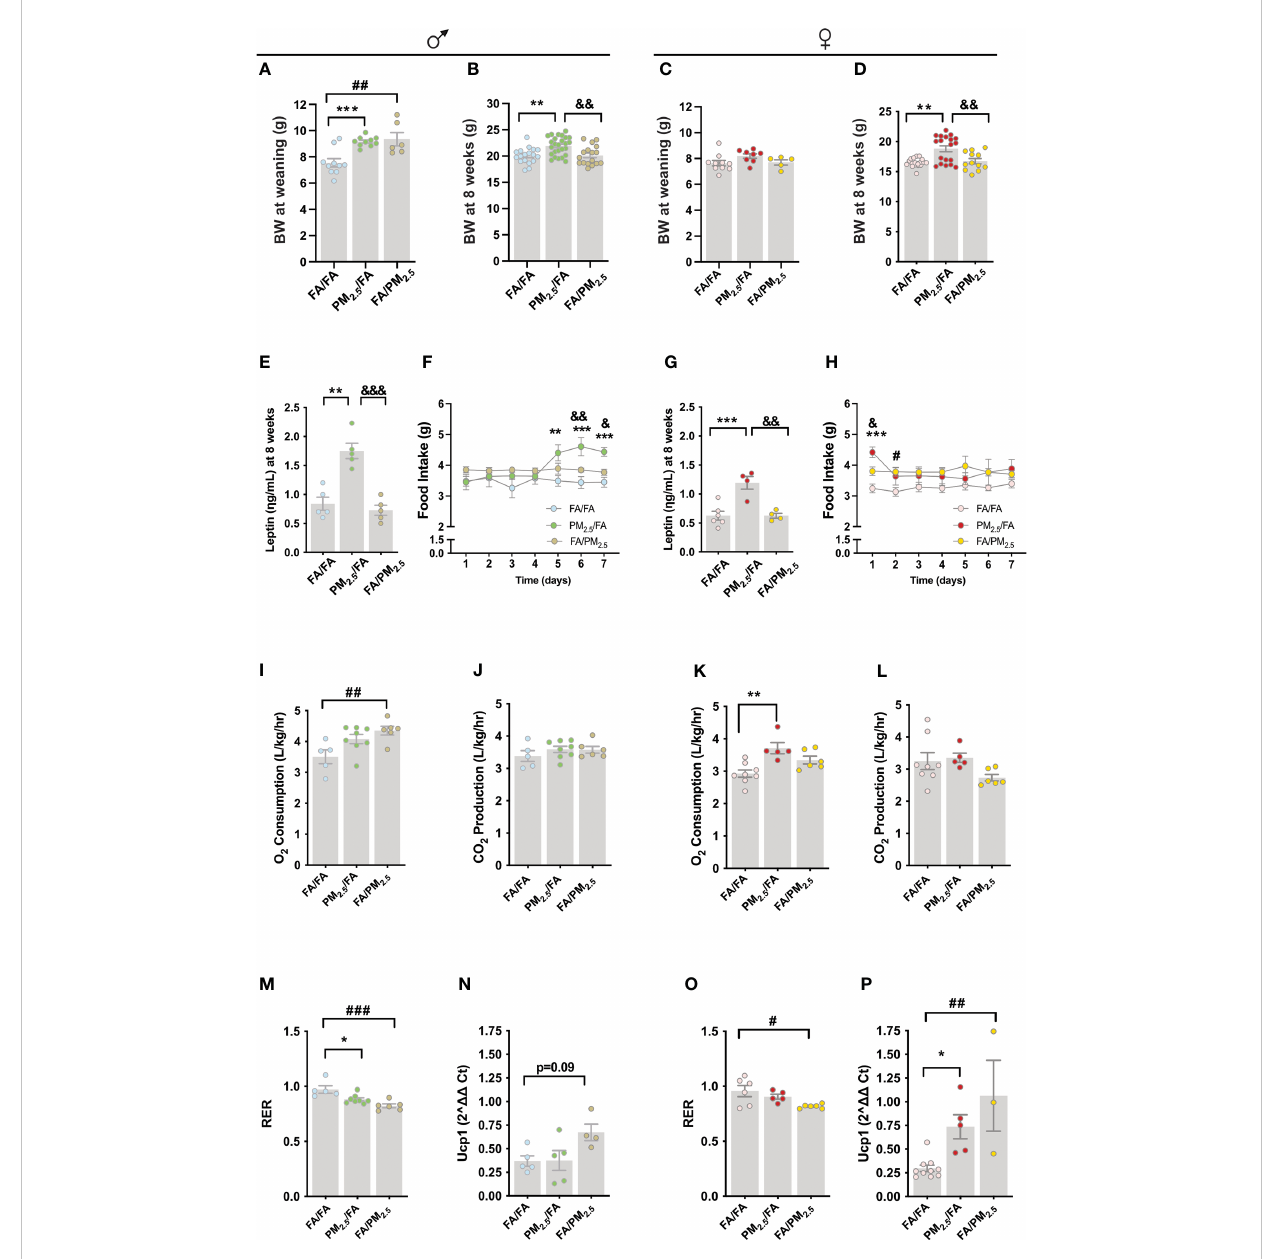
FIGURE 1 Maternal exposure to PM 2.5 alters the energy metabolism of the offspring. (A) Male offspring body weight (g) at weaning, n=6-10. (B) Male offspring body weight (g), n=17-26. (C) Female offspring body weight (g) at weaning, n=5-10. (D) Female offspring body weight (g), n=12-19. (E) Male offspring fasting serum leptin level ( h g/mL), n=5 for each group. (F) Food intake (g), n=5 for each group. (g) Female offspring fasting serum leptin level ( h g/ mL), n=3-6 for each group. (H) Female offspring food intake (g), n=5 for each group. (I) Male offspring oxygen (O2) consumption (L/kg/hr), n=5-8. (J) Carbon dioxide (CO2) production (L/kg/hr), n=5-8. (K) Female offspring O2 consumption (L/kg/hr), n=5-8. L. CO2 production (L/kg/hr), n=5-8. M. Male offspring respiratory exchange ratio (RER), n=5-8. N. Uncoupling Protein 1 (Ucp1) gene expression in the brown adipose tissue (BAT), n=8-13. O. Female offspring RER, n=5-8. P. Ucp1 gene expression in the BAT, n=3-10 from female offspring. Offspring mothers were exposed to PM 2.5 during pregnancy (PM 2.5 /FA) or lactation (FA/PM 2.5 ) and fi ltered air during pregnancy and lactation (FA/FA) as a control group. Panels (B, D, E , G ) mice were 8 weeks. Panels (F) and (H) , mice were 13-14 weeks. Panels (I-P) , mice were 18-19 weeks. Data were expressed as the mean ± SEM. One-way ANOVA was used to analyze Panels (A – E, G) and (I-P) . Two-way ANOVA was used for Panels (F) and (H) We used Bonferroni as a post hoc test and a signi fi cance of P<0.05. p values: ***P<0.001; **P<0.01; *P<0.05 (PM 2.5 /FA vs. FA/FA); &&&P<0.001; &&P<0.01; &P<0.05 (PM 2.5 /FA vs. FA/ PM 2.5 ); ###P<0.001; ##P<0.01; #P<0.05 (FA/PM 2.5 vs.